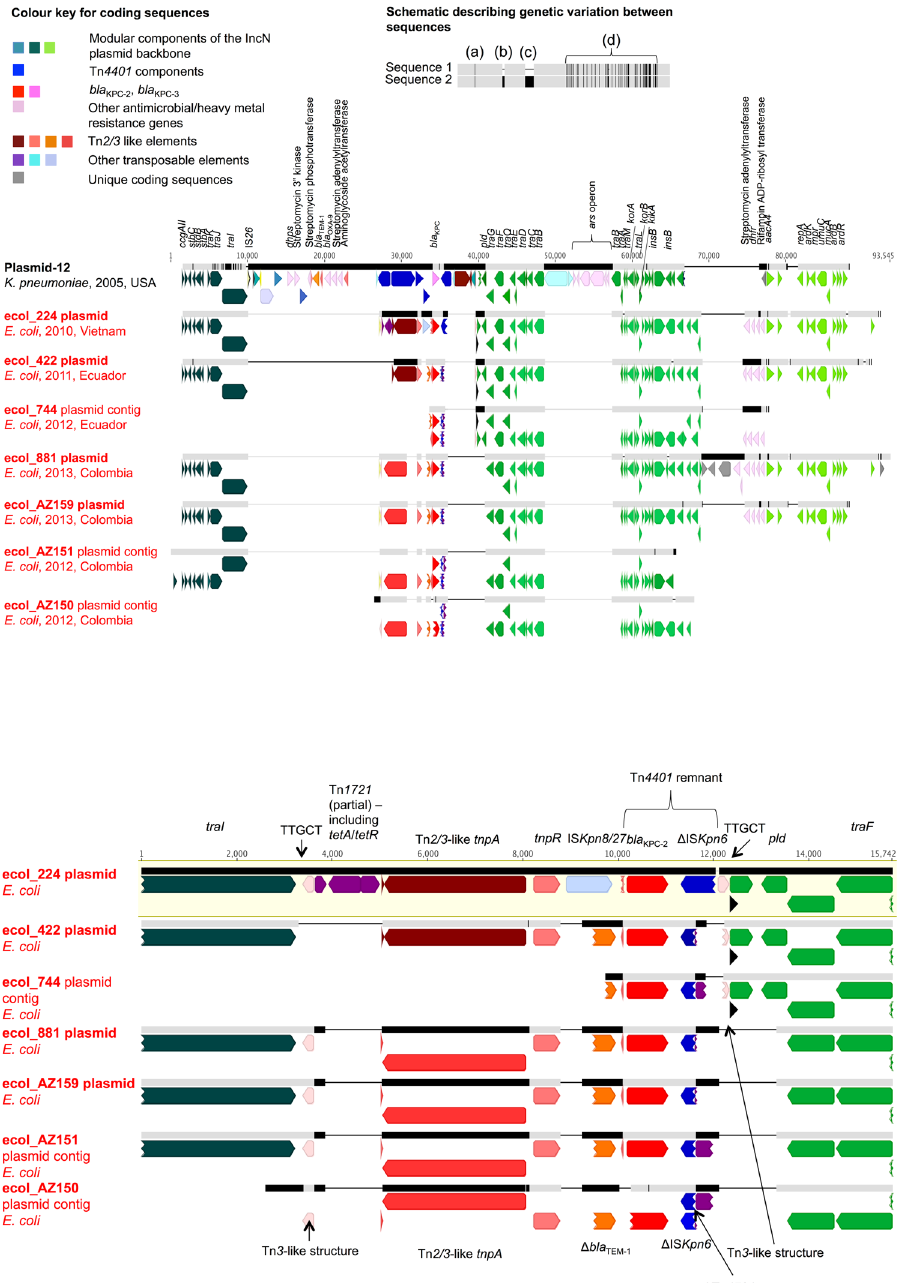
Figure 3. Comparison schematic of FJ223605-like (Plasmid-12-like) IncN KPC plasmids from this study. Panel 3A. Geographic origin, dates of isolation and overall alignment of plasmid/contig structures. Plasmid sequence names in red are those from this study, derived from PacBio data and closed (ecol_224, ecol_422, ecol_881, ecol_AZ159) or incomplete plasmid structures (ecol_744, ecol_AZ151, ecol_AZ150) derived from Illumina data. Aligned bars adjacent to plasmid names represent plasmid sequences: light grey denotes regions with 100% sequence homology; black represents nucleotide diversity between sequences; and thin lines represent indels. Coding sequences are represented by fat arrows below individual sequence bars and are colour-coded as per the colour key. The inset schematic describing genetic variation between sequences depicts examples of evolutionary events identified: ( a ) single nucleotide level change, ( b ) small indels ( ≤ 100 bp), ( c ) large indels ( > 100 bp), ( d ) recombination events. Panel 3B. Close-up of the region between traI and pld containing bla KPC-2 in study isolates only. Coding sequences are colour-coded as in Fig. 3A; sequence regions referred to in the text are